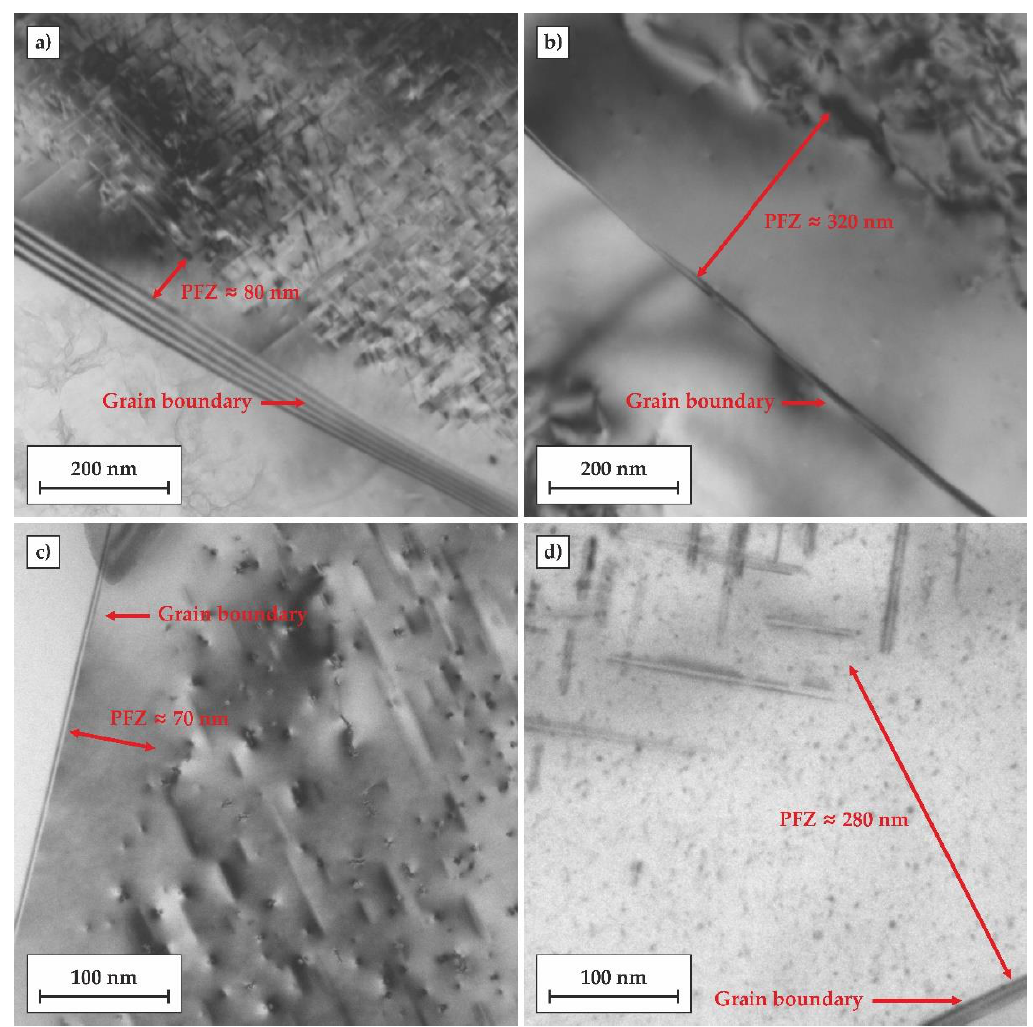
Figure 9. TEM micrographs showing grain boundary regions of the alloy after two investigated heat treatments: ( a , c ) conventional heat treatment to the T6 temper including artificial ageing at 170 °C for 24 h; ( b , d ) quenched directly to the temperature of 170 °C followed by 24 h artificial ageing (T6DA). PFZ, precipitate-free zones.